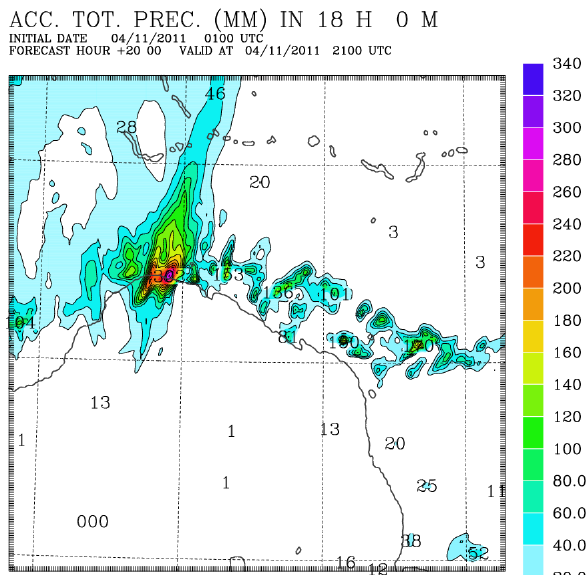
Figure 10. Same as Fig. 9d but for NOAA-GFS analysis. Max. 302mm.